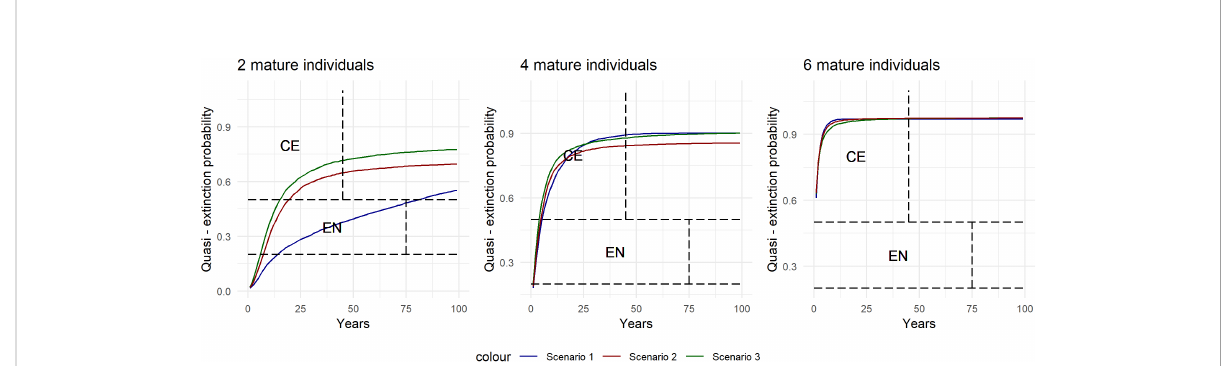
FIGURE 3 Quasi-extinction probability for the common dolphins. Quasi-extinction probability for common dolphins along the Israeli coast for 100 years. The y-axis is the quasi-extinction probability; the x-axis is years. The different scenarios represent increasing levels of growth rates randomness modeled from a normal distribution with increasing standard deviation (from 0 to